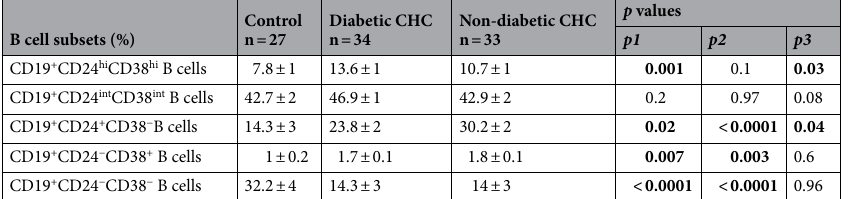
Table 2. CD19 + B cell subsets in chronic hepatitis C patients with respect to T2D. (%) the percentage was calculated from CD19 + B cells. Results expressed as mean ± standard error. Multivariate analysis of covariance (MANCOVA) with age and sex as covariates, Significant p -value is < 0.05 (bold). p 1: Control vs. Diabetic, p 2: Control vs. Non-diabetic, p 3 Diabetic vs. Non-diabetic patients.